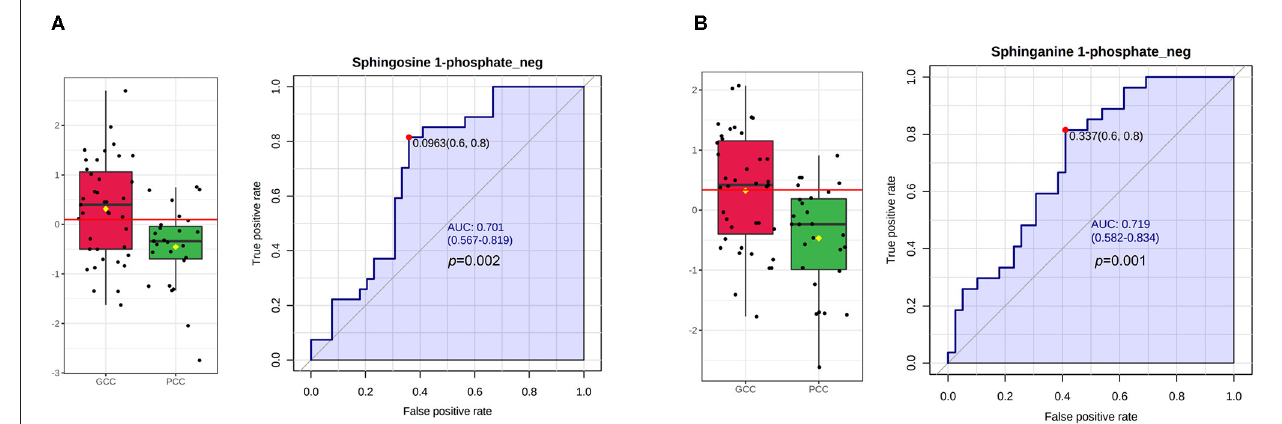
FIGURE 4 | S1P and SA1P levels in GCC and PCC groups and ROC analysis in the discovery stage. (A) Plasma S1P_neg levels were statistically significant between GCC and PCC groups and the ROC analysis of S1P_neg in differentiating GCC and PCC groups. (B) Plasma SA1P_neg levels were statistically significant between GCC and PCC groups and the ROC analysis of SA1P_neg in differentiating GCC and PCC groups. GCC, good collateral circulation; PCC, poor collateral circulation; ROC, receiver operating characteristic curve; AUC, area under the curve; S1P_neg, sphingosine-1-phosphate in negative ion mode; SA1P_neg, sphinganine-1-phosphate in negative ion mode.